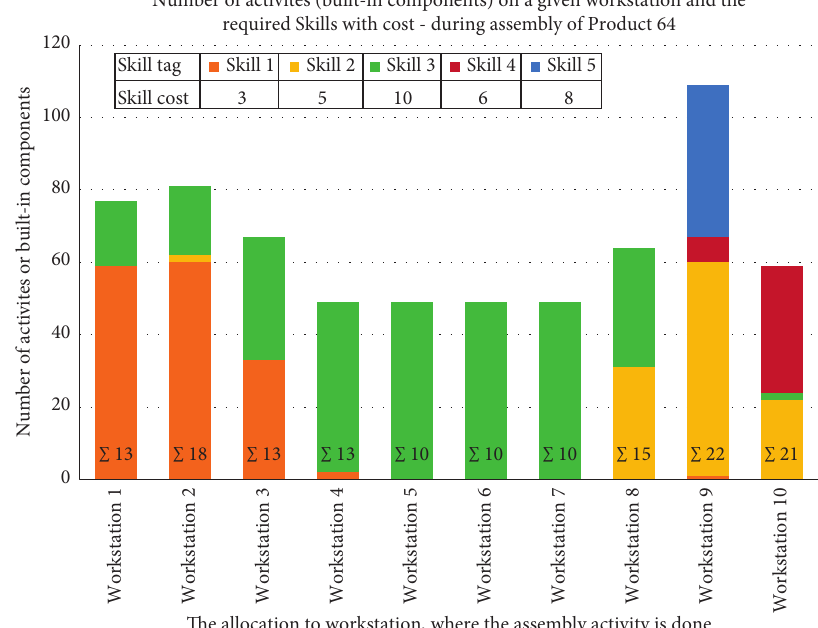
Figure 17: Results of the SPARQL query regarding workstation allocation and skill usage during the assembly of product 64.